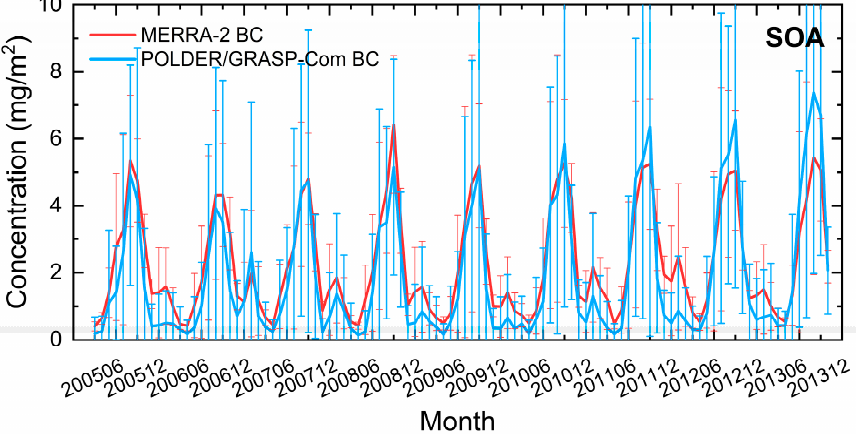
Figure 14. Same as Figure 13, but for Southern Africa (SOA) region. Table 5. The regional differences (Diff.) of BC column concentration for the monthly means during the period March 2005 to October 2013 between MERRA-2 data and POLDER/GRASP component products. Absolute differences (mg/m 2 ) represent MERRA-2 BC minus POLDER/GRASP BC, and relative differences (mg/m 2 ) represent the differences between MERRA-2 BC and POLDER/GRASP BC divided by MERRA-2 BC.